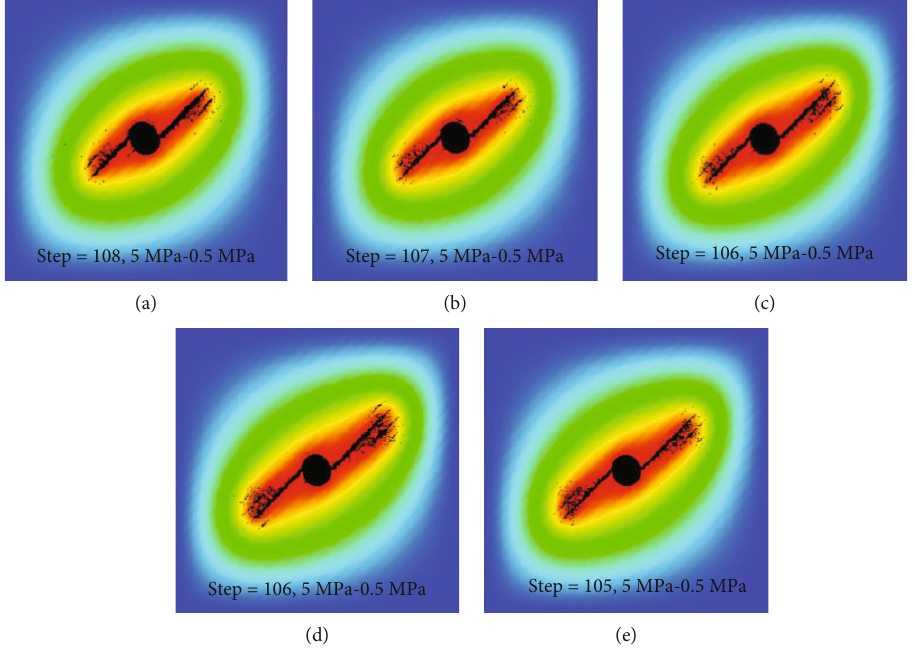
Figure 16: E ff ects of BP elastic modulus on fi nal fracture